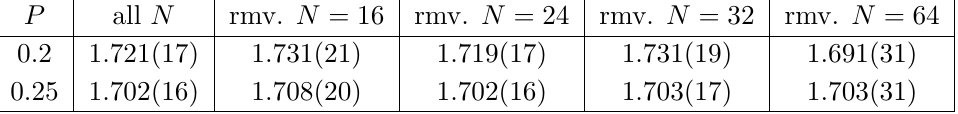
Table 8. Values of c mix for W mix with data for different N removed. Without n t = 16